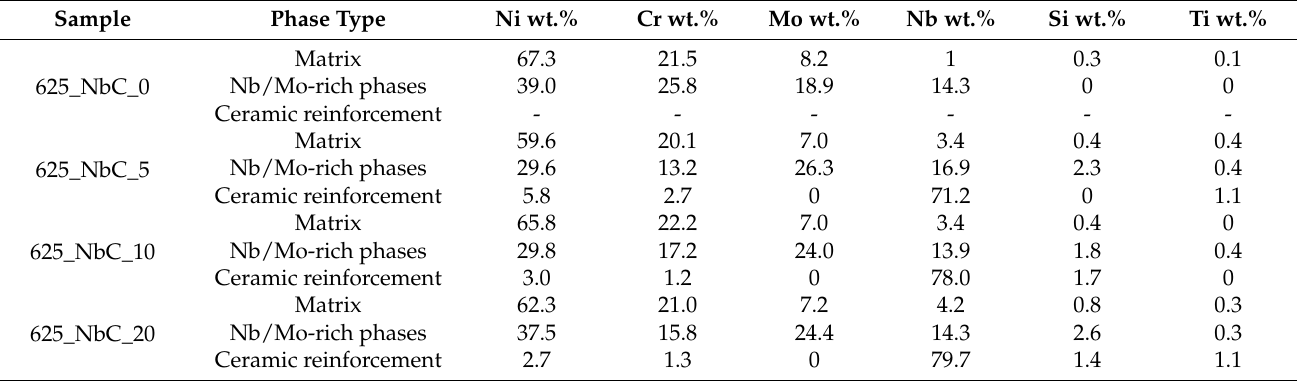
Table 6. EDS qualitative analysis of heat-treated Inconel 625-NbC materials.